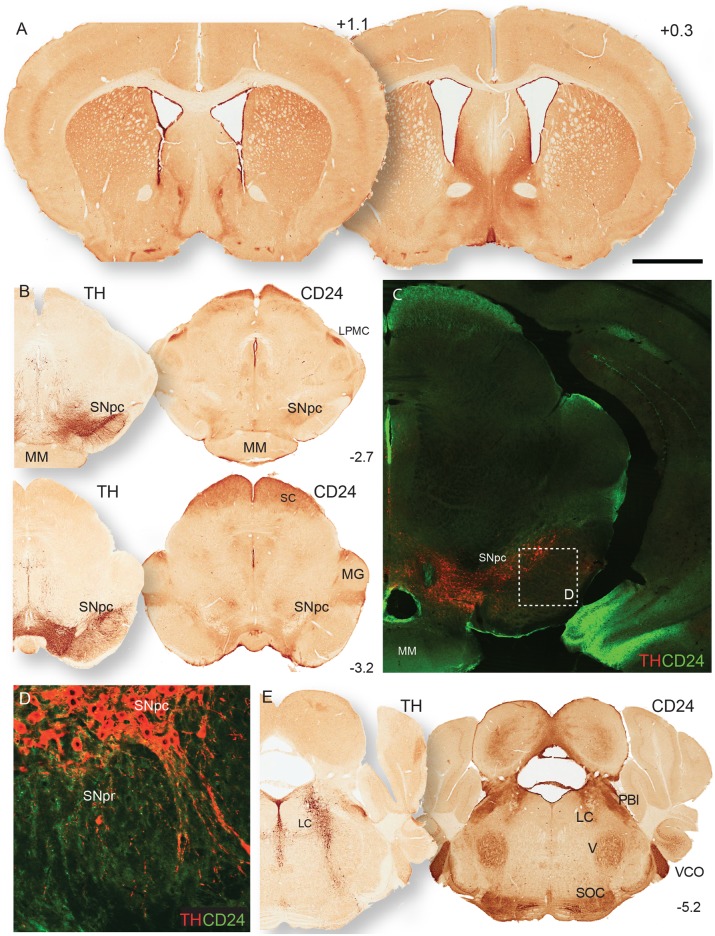
CD24 protein expression pattern in the adult mouse brain.(A) CD24 expression in the mouse forebrain at two levels of the striatum. (B) Coronal sections of the midbrain at the level of the caudal end of the mammillary bodies (MM). TH staining on the left section indicates the location of the dopamine neurons of the SNpc. CD24 labels DA neurons in the SNpc, as well as the lateral posterior thalamic nucleus (LPMC), superior colliculus (SC), and nuclei surrounding the medial geniculate (MG). (C) Immunofluorescent staining of TH and CD24 indicates some localisation in the SNpc. Dashed line box highlighting area of the high magnification image in panel D. (D) CD24 staining on TH+ DA neurons in the SNpc, labelling dendritic fibres projecting down into the substantia nigra pars reticulata (SNpr). (E) TH and CD24 staining in the hindbrain where the LC is labelled by both. Co-ordinates in the right hand corners of panels A, B & E indicate the location of the coronal plane relative to bregma. The scale bar in panel A represents 800μm in panel A&E, 500μm in panel B, 200μm in panel C, and 50μm in panel D.